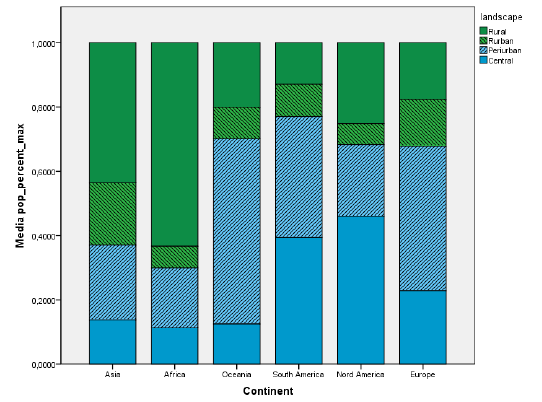
Figure 16. Population by landscape and continent